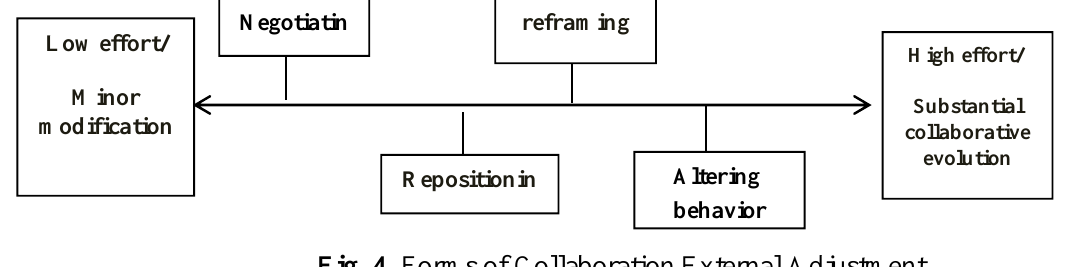
Fig. 4. Forms of Collaboration External Adjustment (Gibson & Dibble,